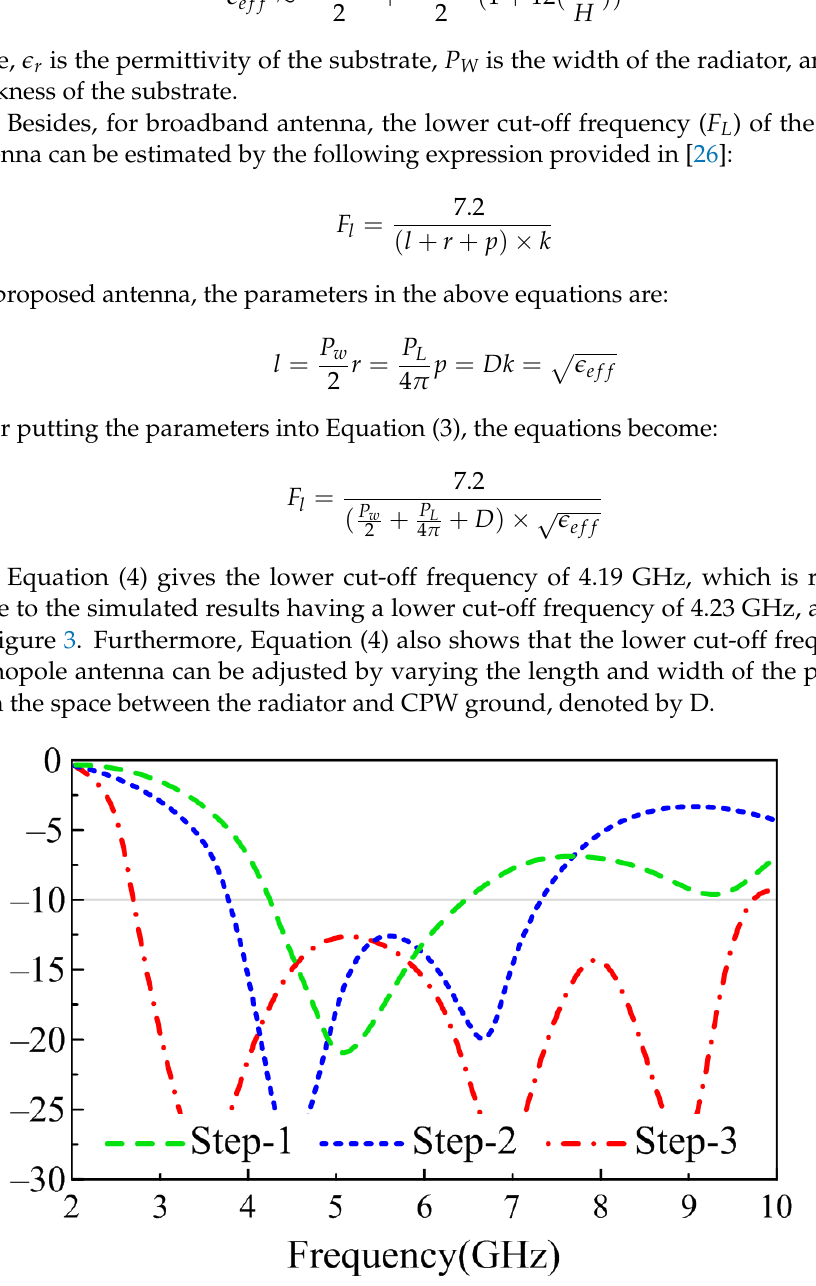
Figure 3. |S 11 | of the various antenna involve in designing of proposed work.